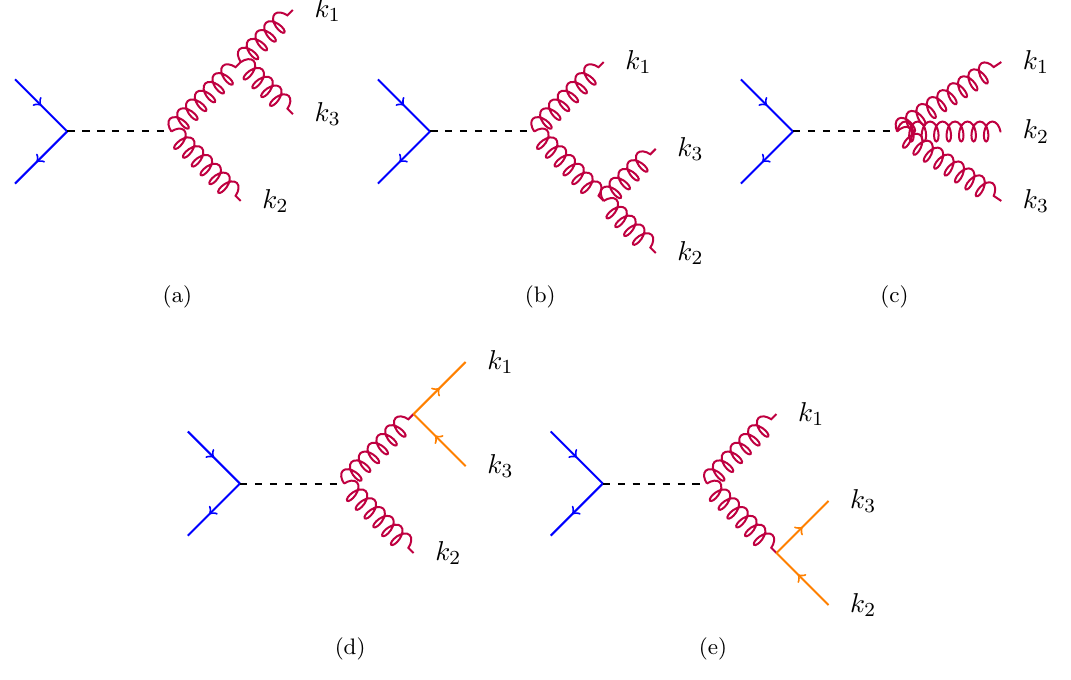
Figure 20 . Feynman diagrams for (a,b,c) e + e (cid:0)